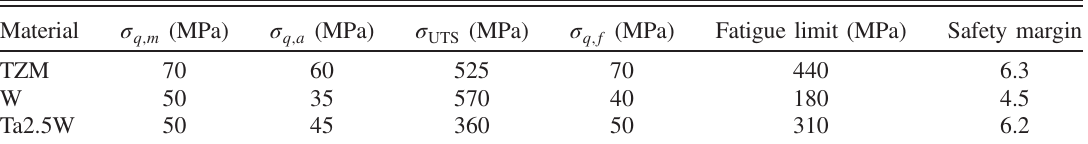
TABLE VI. Equivalent mean stress ( σ q;m ), stress amplitude ( σ q;a ) and fully reversed stress ( σ q;f ) calculated for the BDF target materials. Comparison with the fatigue strength of the materials for 10 7 cycles [13,32,41].